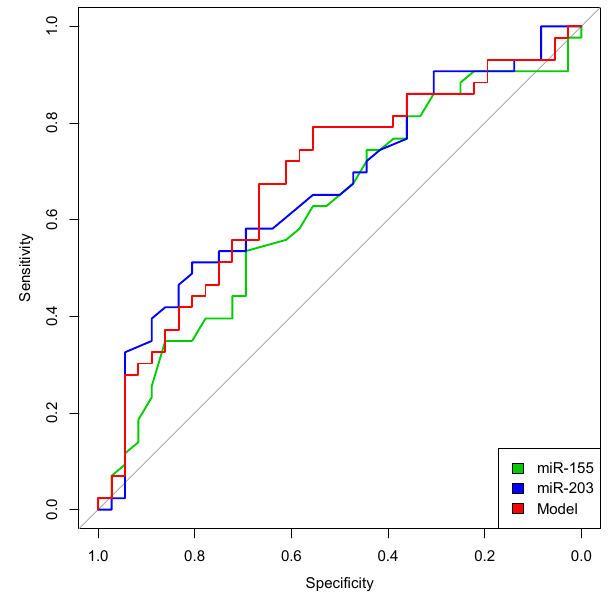
Figure 2. ROC analyses for miR-155 (green), miR-203 (blue) and a combination of miR-155 + miR-203 (model in red) and their prognostic application. Both microRNAs exhibited fair area under the curve values (AUCs; miR-155: AUC 0.62 (0.49–0.74), p = 0.067; miR-203: AUC 0.67 (0.55–0.79), p = 0.011).